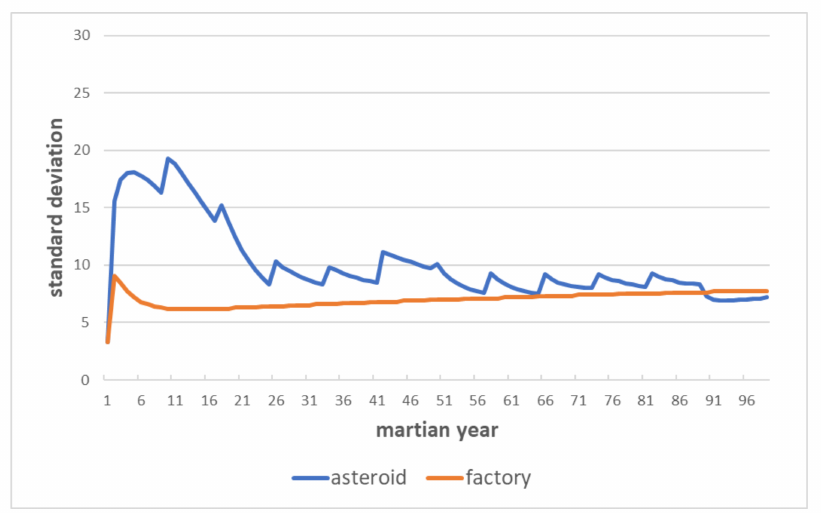
Figure 22. Standard deviation of the temperature rise on Mars over 100 simulation years after the